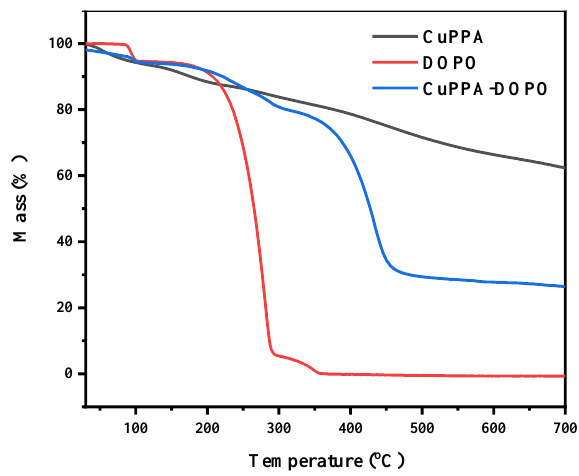
Figure 2. TGA curves of CuPPA, DOPO and